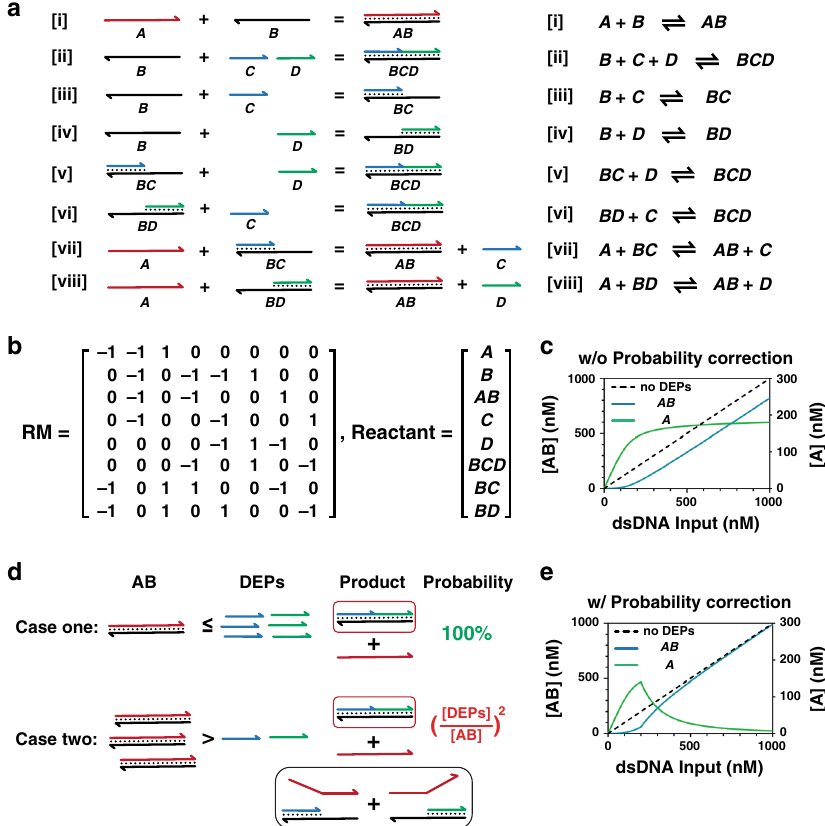
Fig. 3 Theoretical model of DNA Equalizer Gate (DEG). a Schematic illustration of all possible elemental reactions occurring in the DEG. b Linearization of the complex reaction network in DEG into 0 = RM·Reactant to extract the independent equations, where RM is the stoichiometric matrix and Reactant represents DNA species. The rank of RM was determined to be 4, indicating that four independent equilibrium equations need to be solved. As such, reactions [i - iv] were chosen to build mathematical model. c In silico prediction of the yields of A and AB as a function of the concentration of dsDNA target without performing the probability correction. d Schematic illustration of the need for probability correction when [AB]> [DEPs]. As each DEP binding is an independent event, the multiplicity rule was applied here. When [AB] ≤ [DEPs], the probability that two DEPs bind to the same B is 100%. However, when [AB]> [DEPs], the probability becomes dependent on the ratio between the initial concentrations of AB and DEPs, where Probability